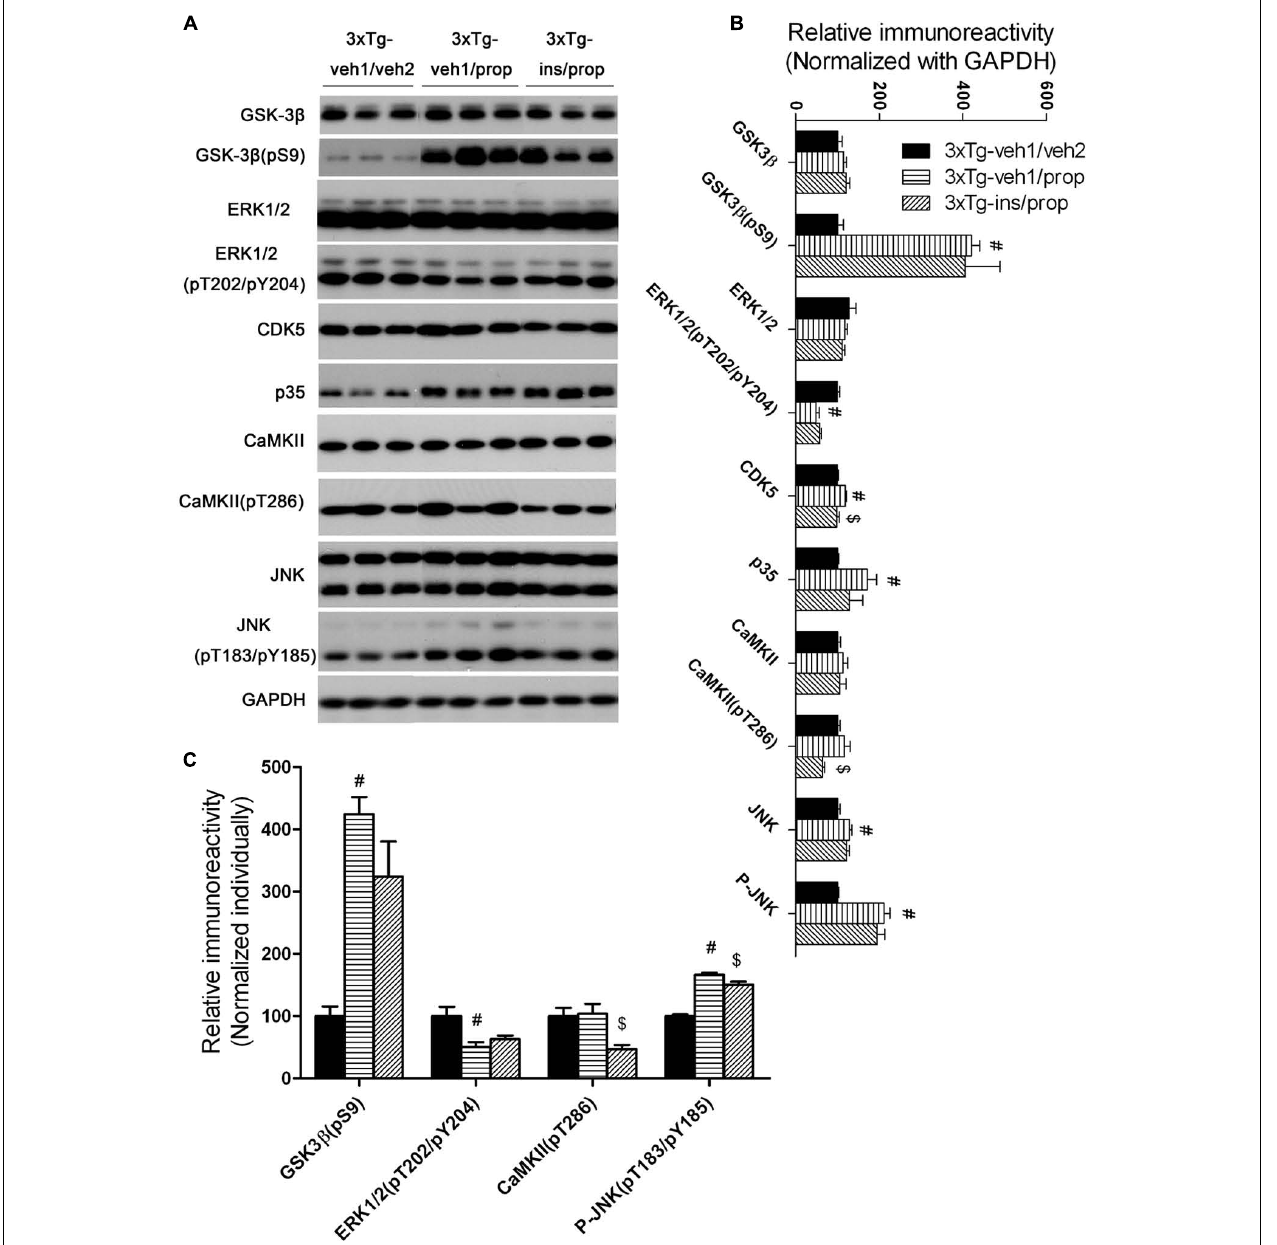
FIGURE 7 | Effect of propofol and intranasal insulin treatments on tau kinases. (A) Homogenates of the rostral halves of mouse brains were analyzed by Western blots developed with antibodies indicated at the left side of the blots. (B,C) Densitometrical quantifications